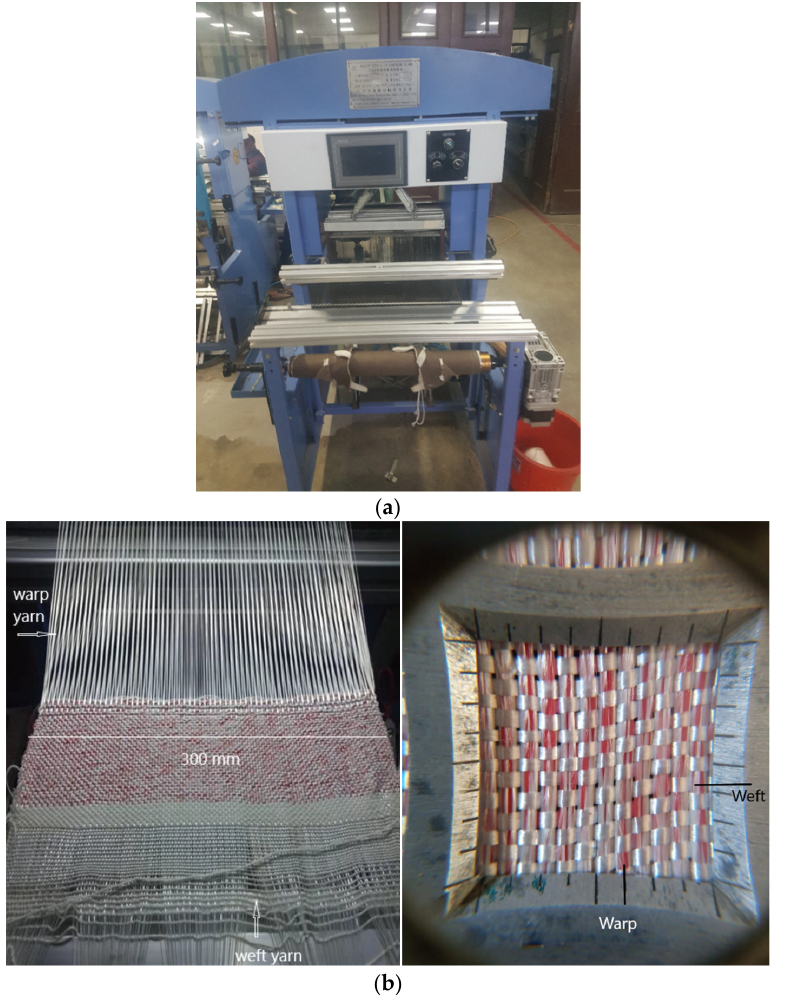
Figure 2. ( a ) Semi-automatic dobby weaving Loom used for making fabric samples in this study. ( b ) Fabric sample during production stage. Closer view of the fabric is shown on the right clearly showing warp and weft yarns.